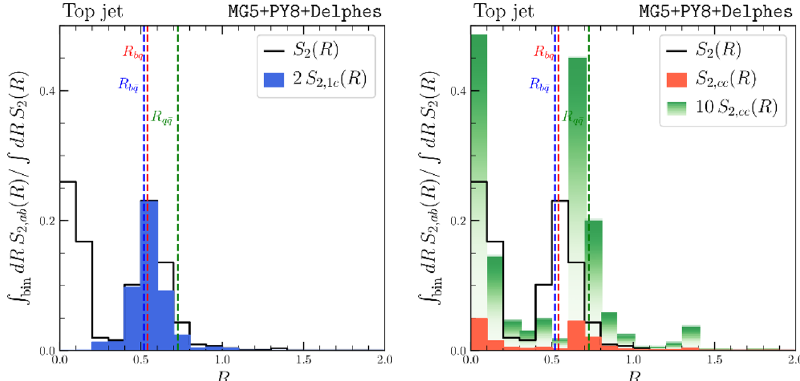
Figure 5. Same as (cid:12)gure 4 but the top jet in (cid:12)gure